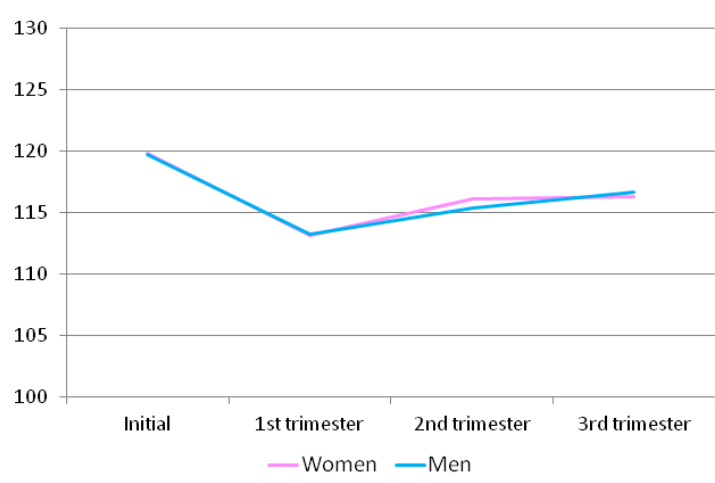
Figure 3. Passion scores for the men and women at different time points throughout pregnancy.